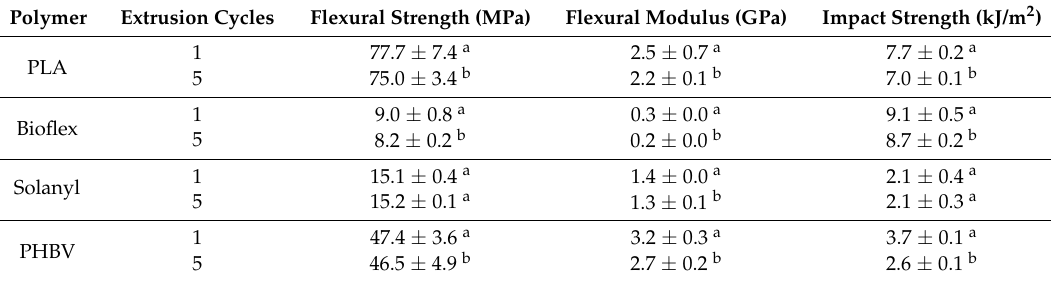
Table 6. Changes in mechanical properties of the polymers after the recycling